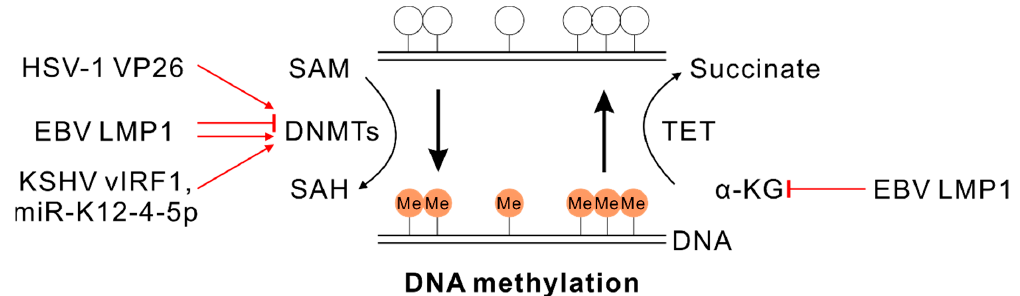
Figure 1. Herpesviruses regulate DNA methylation by targeting metabolic enzymes or intermediates. EBV-encoded LMP1 can promote or inhibit DNMT activity dependent on the specific cell types. Herpesviruses-associated regulation is highlighted with a red line. DNA methylation is labeled with an orange solid circle. DNMT, DNA methyltransferase; SAM, S-adenosylmethionine; SAH, S-adenosyl homocysteine; TET, ten-eleven translocation methylcytosine dioxygenase; α -KG, α -ketoglutarate.